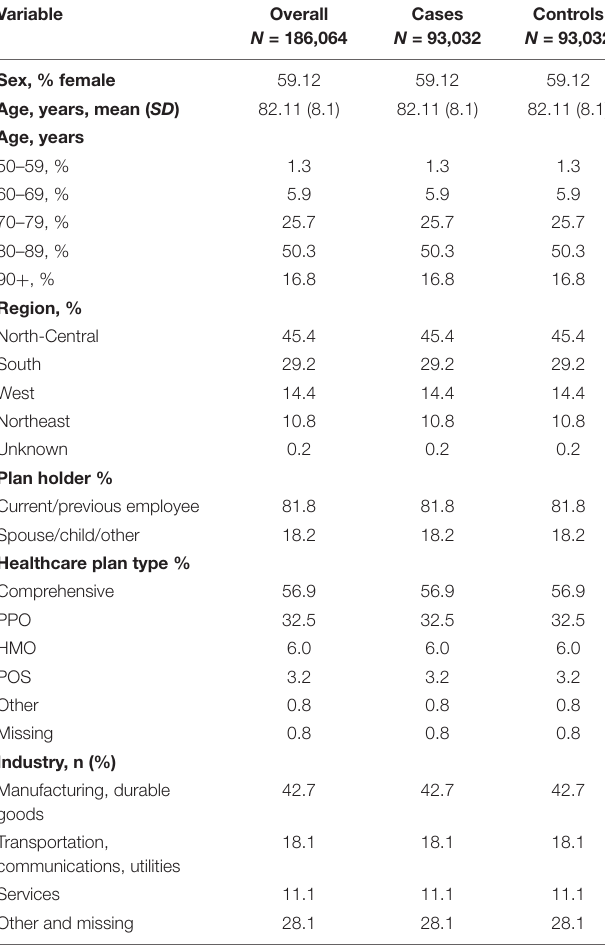
TABLE 1 | Demographic characteristics. TABLE 2 | Comorbidities with the highest pooled prevalence across cases and